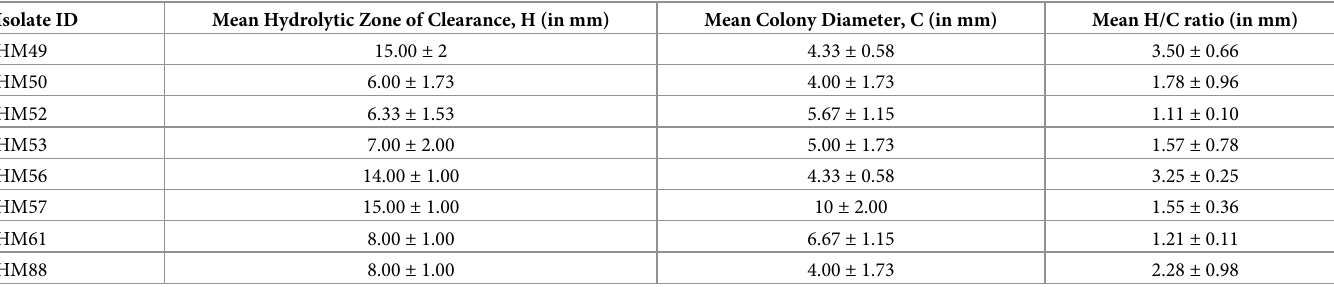
Table 1. Preliminary screening of isolated bacteria for their proteolytic activity. Isolate ID